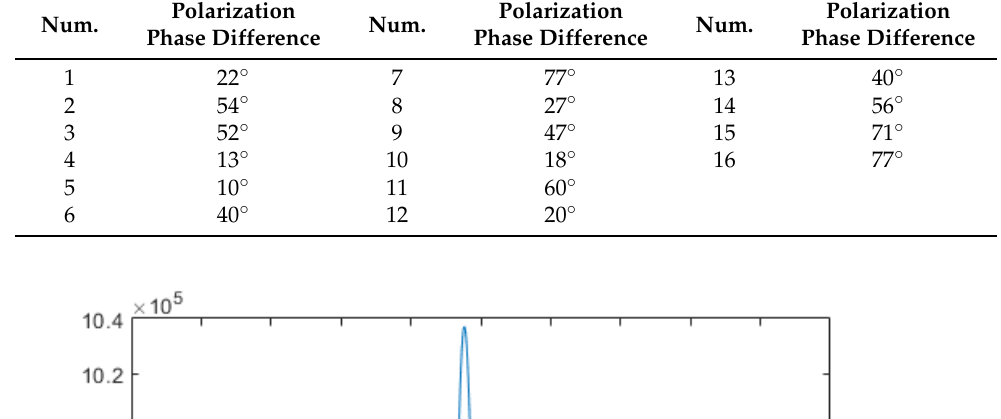
Table 1. The polarization phase difference of interference in different pulses. Num.